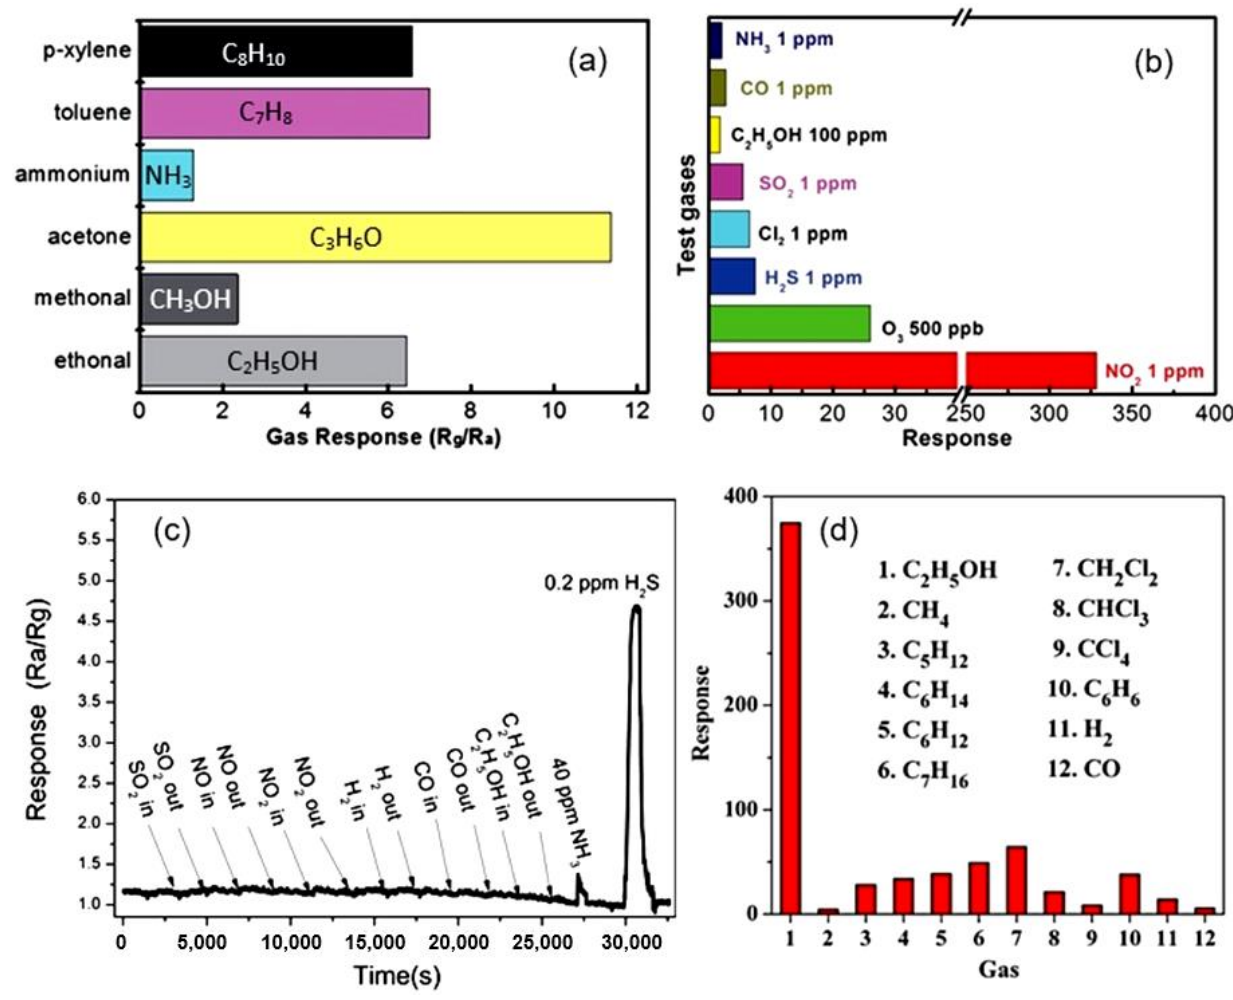
Figure 13. ( a ) The conductometric responses of sensors based on porous 2D Co 3 O 4 nanosheets to several reducing gases with concentrations of 100 ppm at 150 °C. Reprinted with permission from [106]. Copyright 2015: RSC; ( b ) Cross ‐ responses of the sensor based on 2D porous In 2 O 3 nanoflakes